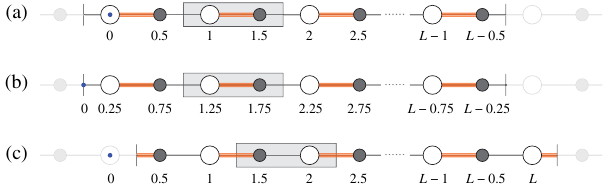
FIG. 1. (a) A lattice with two sites ( x 1 ¼ 0 and x 2 ¼ 0 . 5 ) in a unit cell. The lattice constant a is set to 1. (b) The origin (shown by the blue dot) is shifted by − 0 . 25 , and the lattice position becomes x 1 ¼ 0 . 25 and x 2 ¼ 0 . 75 . (c) A different unit cell is chosen, which includes x 1 ¼ 1 and x 2 ¼ 0 . 5 .